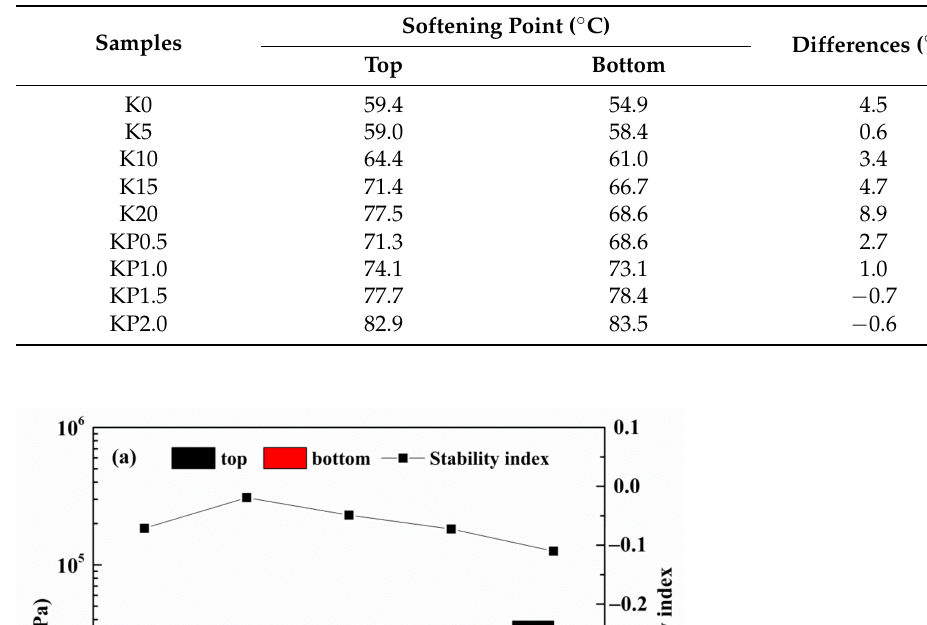
Table 10. Softening point differences of modified asphalt binders.